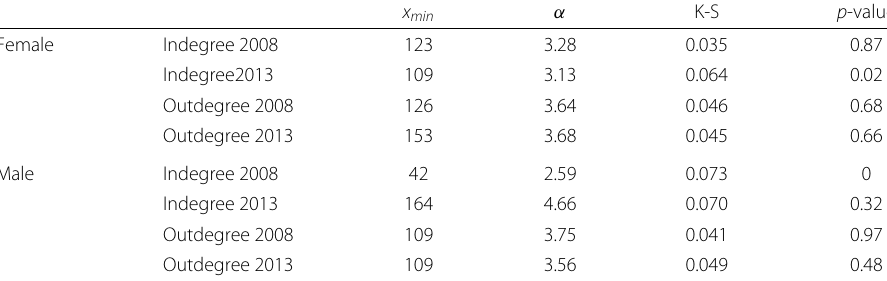
Table 6 Estimated parameter and lower bound for a power law fitted model with relative K-S statistic and p -value for the goodness-of-fit test x min α K-S p -value Female Indegree 2008 123 3.28 0.035 0.87 Indegree2013